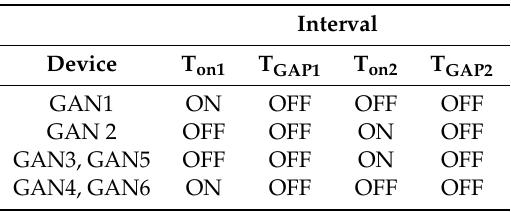
Table 1. Transistors conditions for each state.